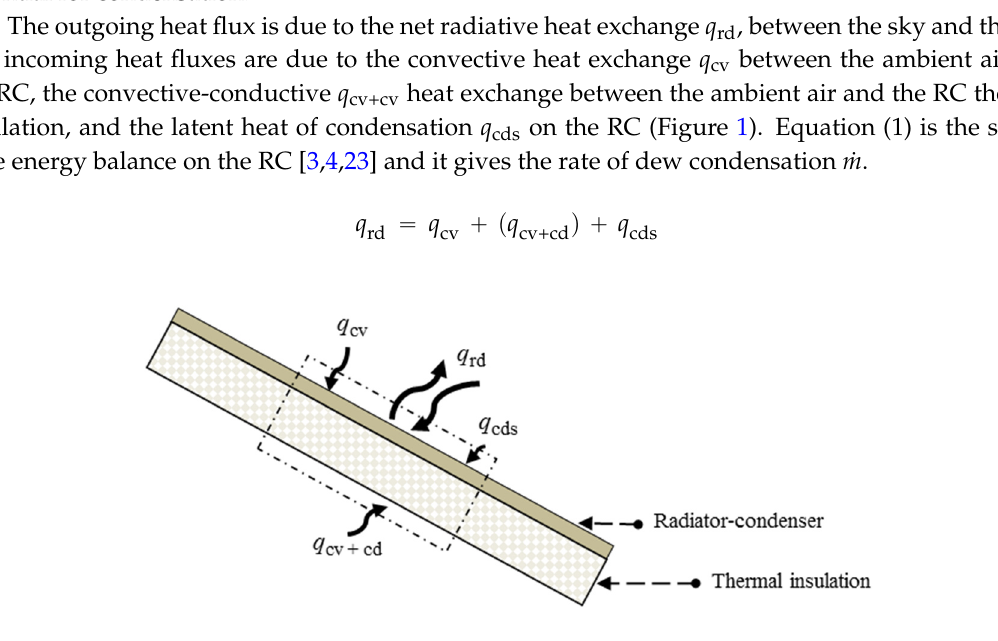
Figure 1. Steady state energy balance on the dew collector.